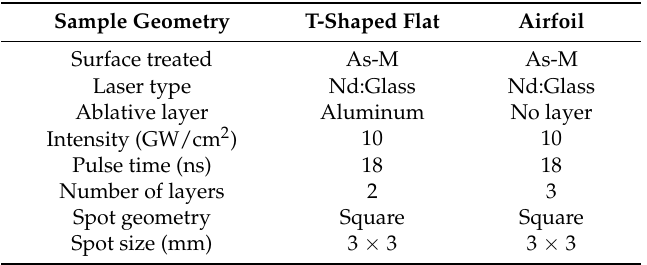
Table 1. Laser shock peened (LSP) processing parameters and conditions.